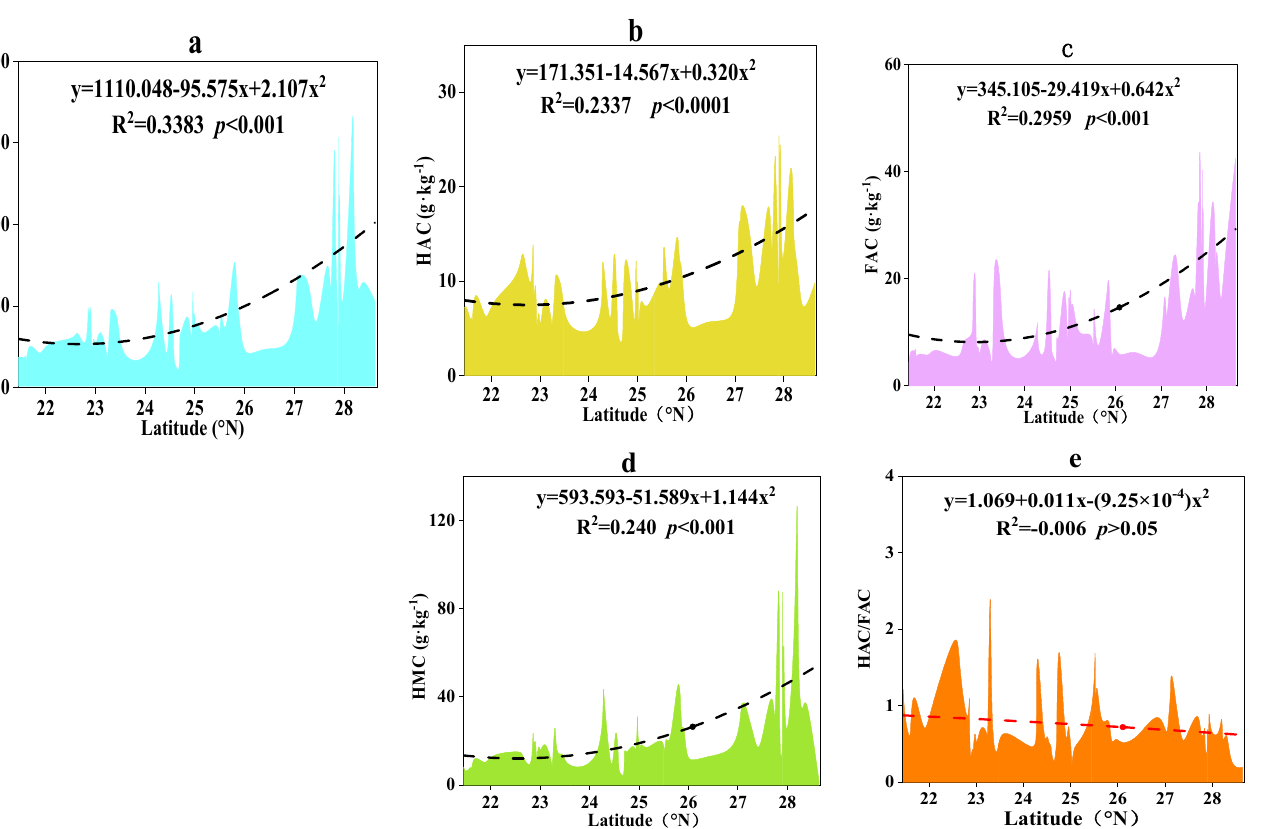
Figure 7. Relationship between latitude and the composition of soil organic matter (figure ( a ): SOC; figure ( b ): HAC; figure ( c ): FAC; figure ( d ): HMC; figure ( e ): HAC/FAC). FAC, fulvic acid carbon; HA/FA, humic acid/fulvic acid; HAC, humic acid carbon; HMC, humin carbon; SOC, soil organic carbon.